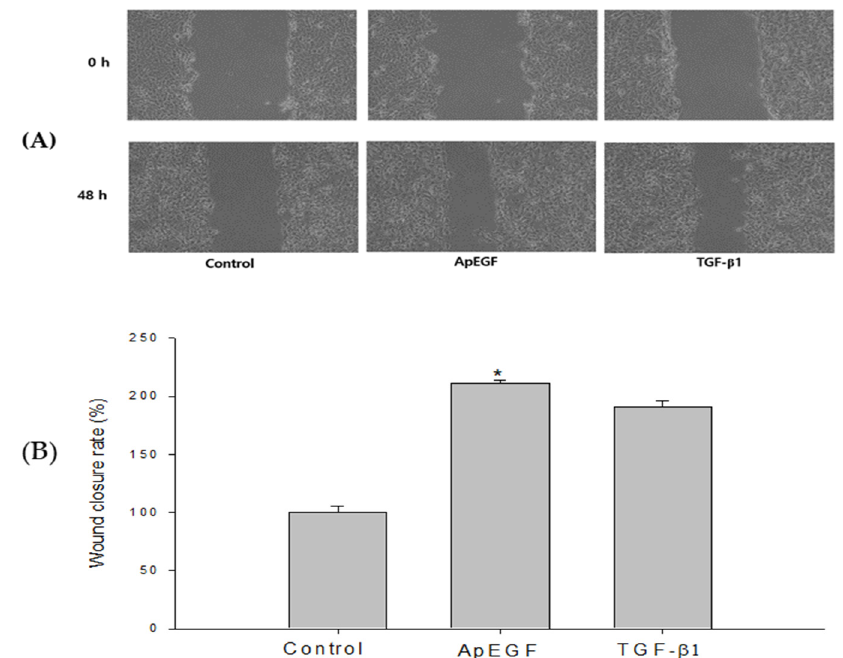
Figure 5. Wound-healing efficiency of the control, truncated ApEGF, and TGF- β 1 in vitro . ( A ) Gross wound-size changes during wound healing in each group. Scratch-wound healing of HaCaT confluent monolayers. HaCaT cells were seeded in 6-well plates at a density of 8 × 10 5 cells/well and maintained in DMEM medium supplemented with 10% fetal bovine serum containing 5% CO 2 at 37 °C. The picture was taken at 0 h and 48 h after treatment with truncated ApEGF or TGF- β 1. ( B ) Longitudinal analysis of wound healing in each group. When the round scratch was performed, the percentage by control was calculated by measuring the narrowed average distance of 48 h. *, p < 0.05, statistically significant versus the control.